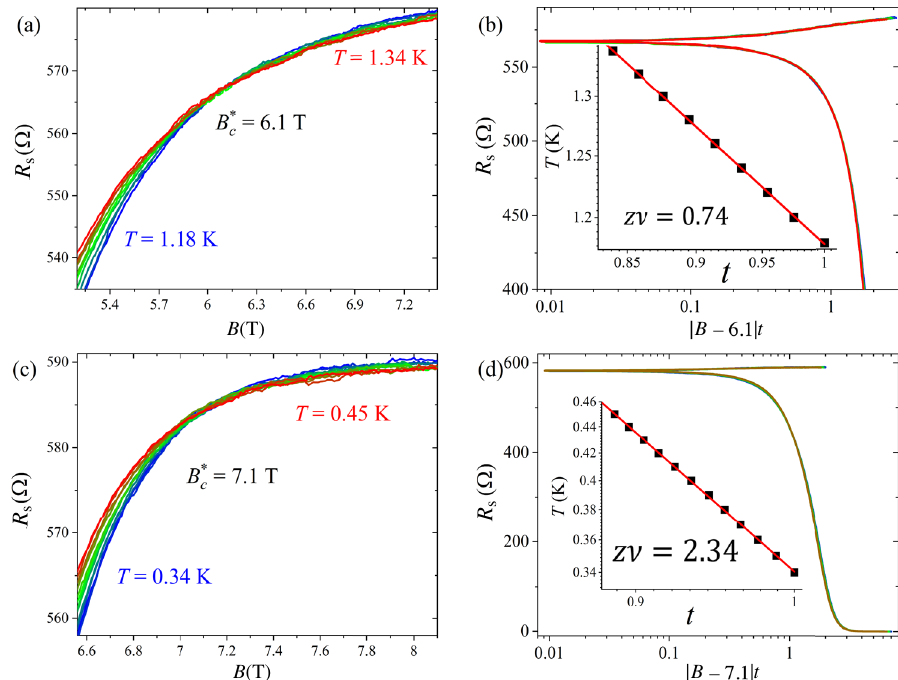
Fig. 5 Scaling analysis on the superconductor-to-insulator quantum phase transitions of the 2 µ m-wide bridge. a Sheet resistance R s as a function of magnetic fi eld at temperatures between 1.18 and 1.34 K, showing a distinct crossing point of the fi rst T max plateau at the re-entrance fi eld to ¼ 6 : 1T. b Scaling-analysis plot of R superconductivity B (cid:6) as a function of B (cid:3) 6 : 1 j j t . Inset: temperature dependence of the scaling parameter t , with a s c product of the correlation length and dynamical exponents z ν ¼ 0 : 7365. c Sheet resistance as a function of fi eld R s B ð Þ at temperatures between 0.34 and ¼ 7 : 1T. d Scaling-analysis plot within the critical regime at 7.1 T. Inset: temperature 0.45 K, showing the crossing point of the T plateau at B (cid:6) max c dependence of the scaling parameter t , with z ν ¼ 2 : 3443.